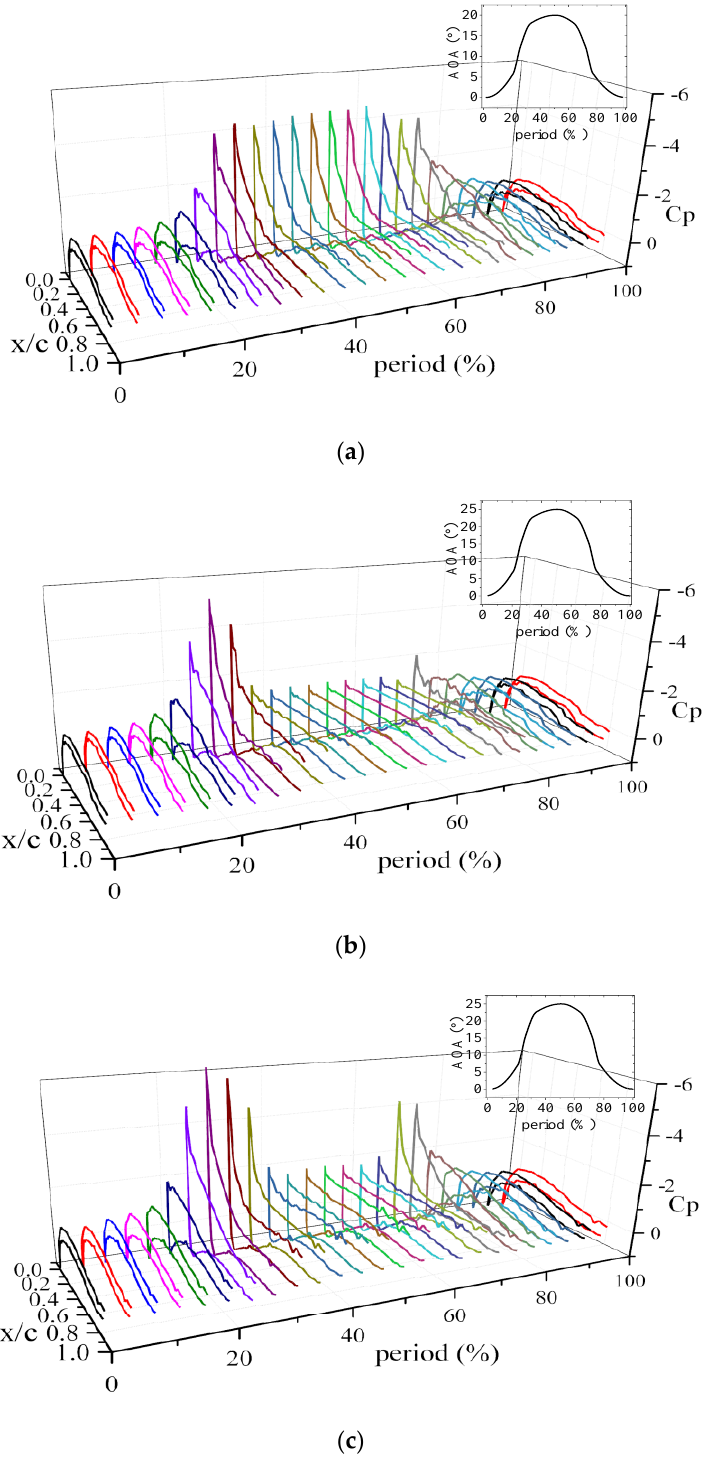
Figure 5. Comparison of the Cp distributions in an oscillatory period. ( a ) uniform inflow, A = 10, α mean = 10; ( b ) uniform inflow, A = 12.5, α mean = 12.5; ( c ) T.I. of 10.18%, A = 12.5, α mean = 12.5.